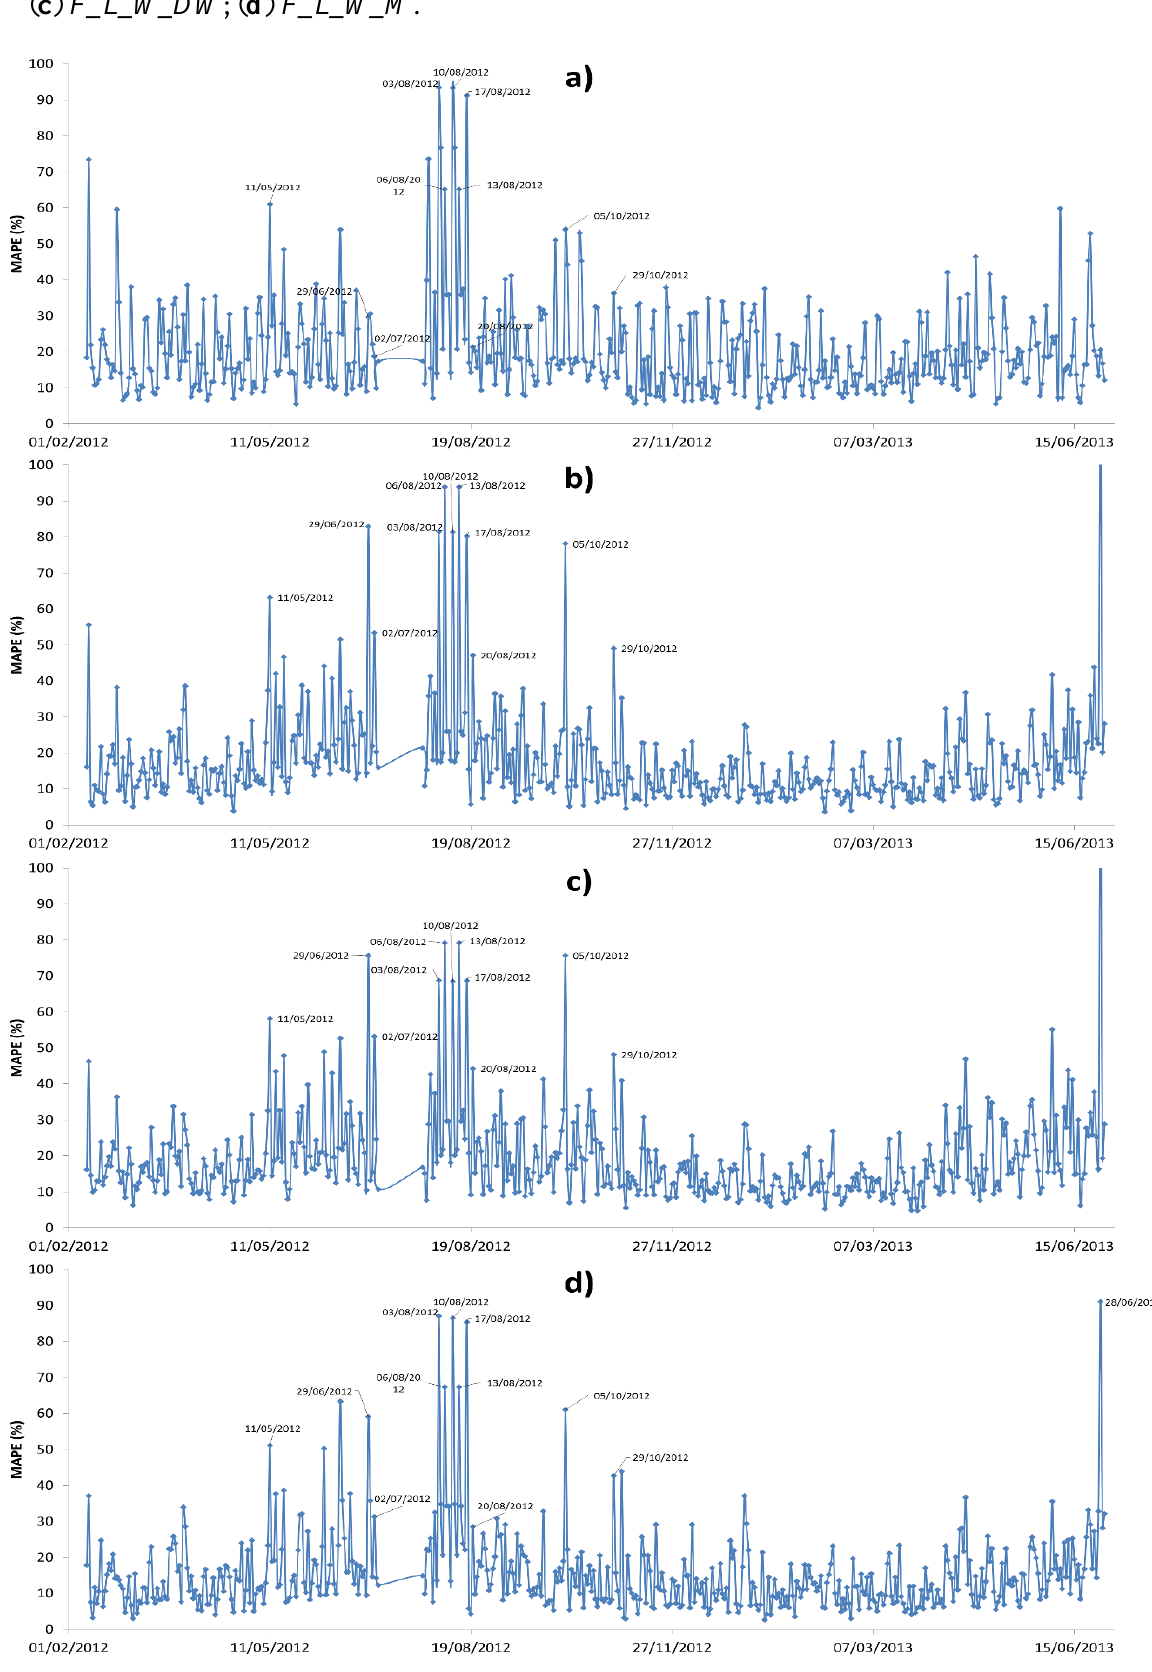
Figure 8. Daily Average MAPE (%) (1) of the winning architecture: ( a ) F_L ; ( b ) F_L_W ; ( c ) F_L_W_DW ; ( d ) F_L_W_M